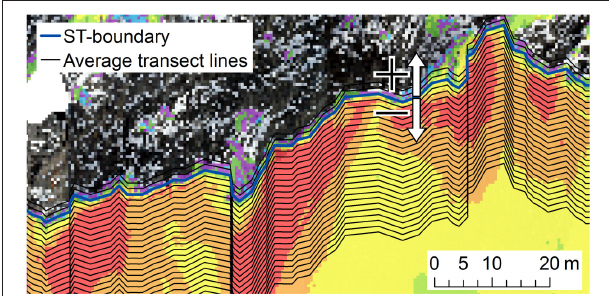
FIGURE 10 | Illustration of how the average transects in Figures 9 and 11 were calculated. The mean values were calculated along the average transect lines. Only every second line is shown. The ST-boundary is defined by the snow cover extent of 21 March. The location of this detail is shown in Figure 5 . The arrows show in which direction the distance is positive or